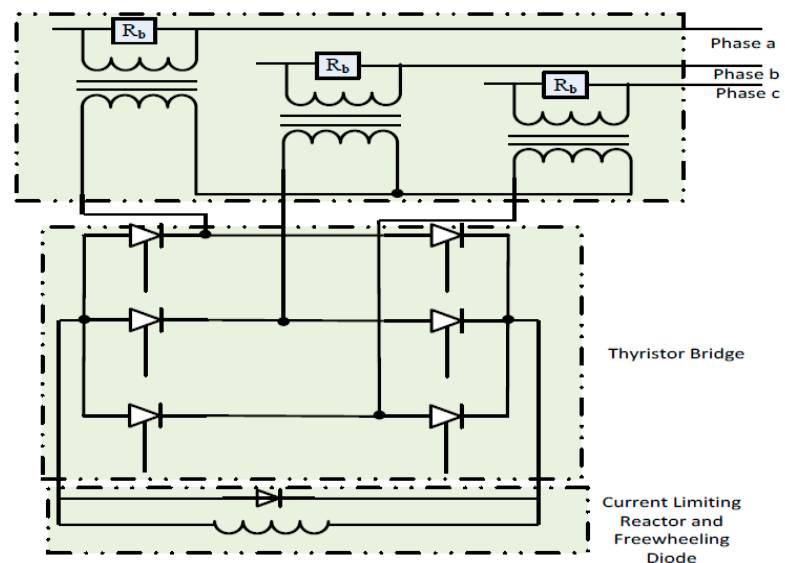
Figure 20. Basic diagram of transformer-coupled bridge FCL.